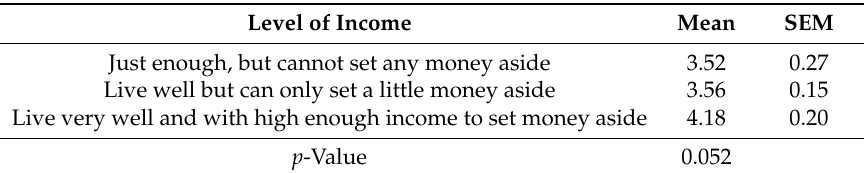
Table 3. Preference for animal products that originated from animals fed with insect meal, depending on the household income of respondents, on a 1–7